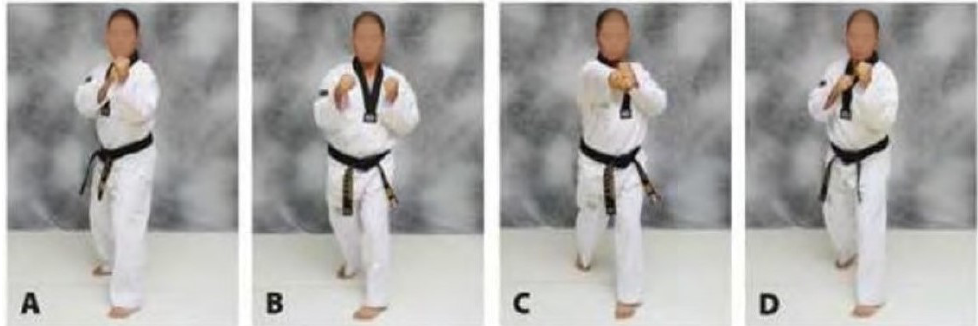
Figure 2. The Taekwondo reverse-step punch ( A ) Fighting stance, ( B ) Launching punch with rear hand while rotating the hip, ( C ) Fully extended punch with rear hand, ( D ) Retracting striking hand back to fighting stance